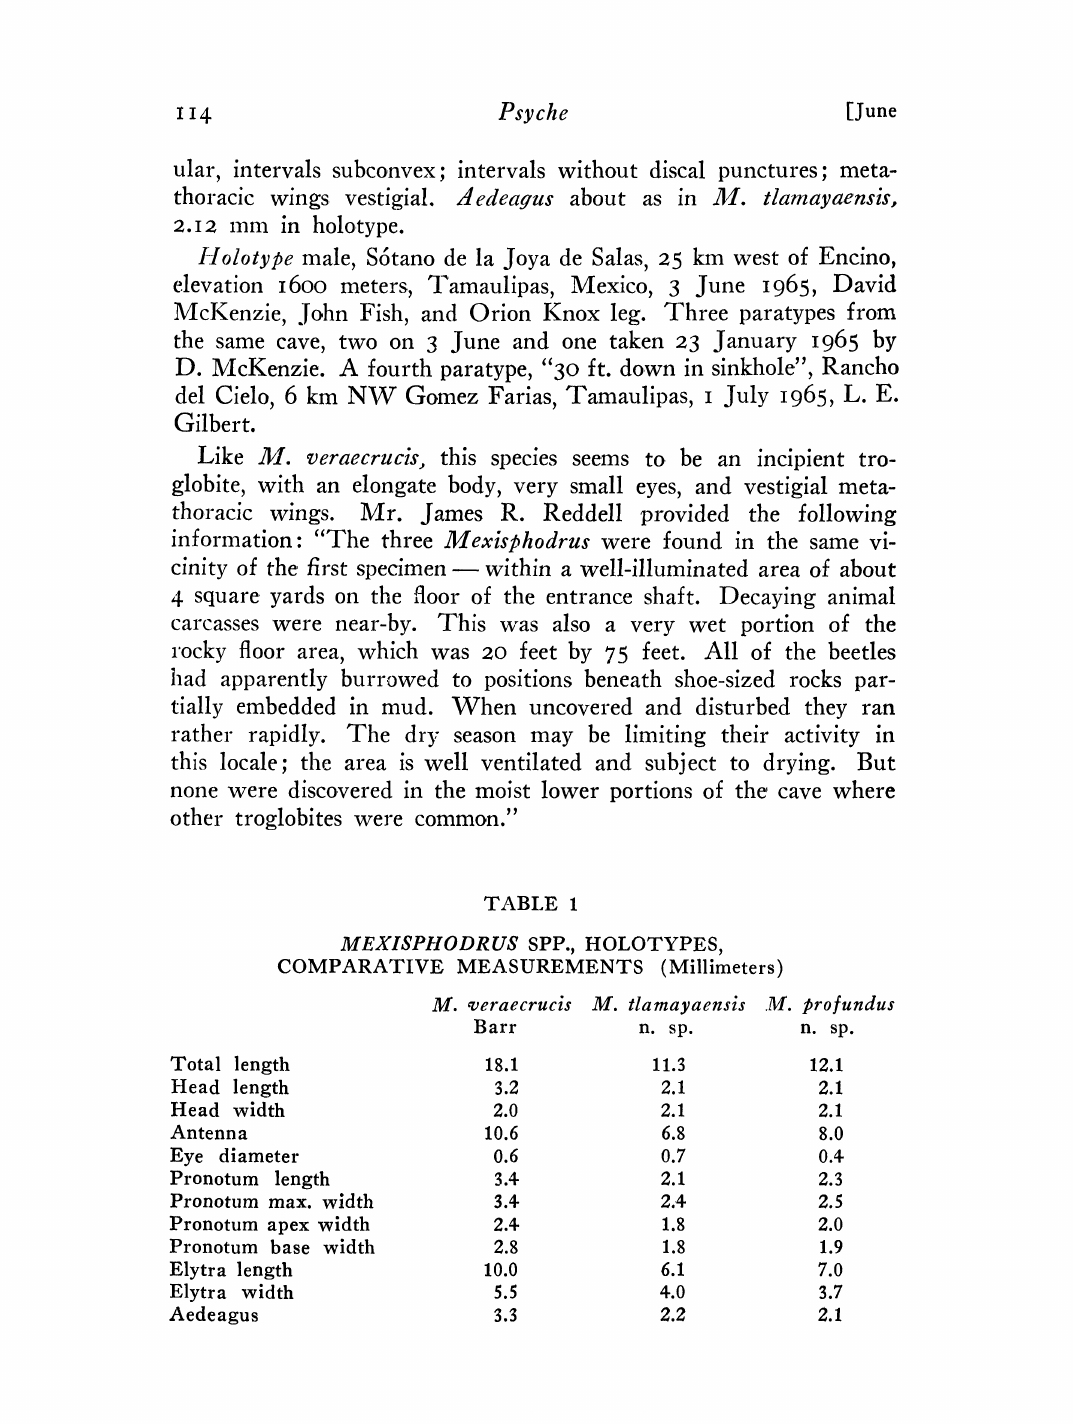
MEXISPtlODRUS SPP., HOLOTYPES, COMPARATIVE MEASUREMENTS